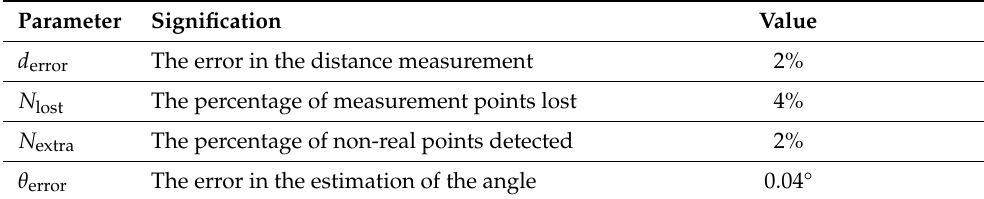
Table 1. Parameters of the simulations meant to imitate real-world Lidars.